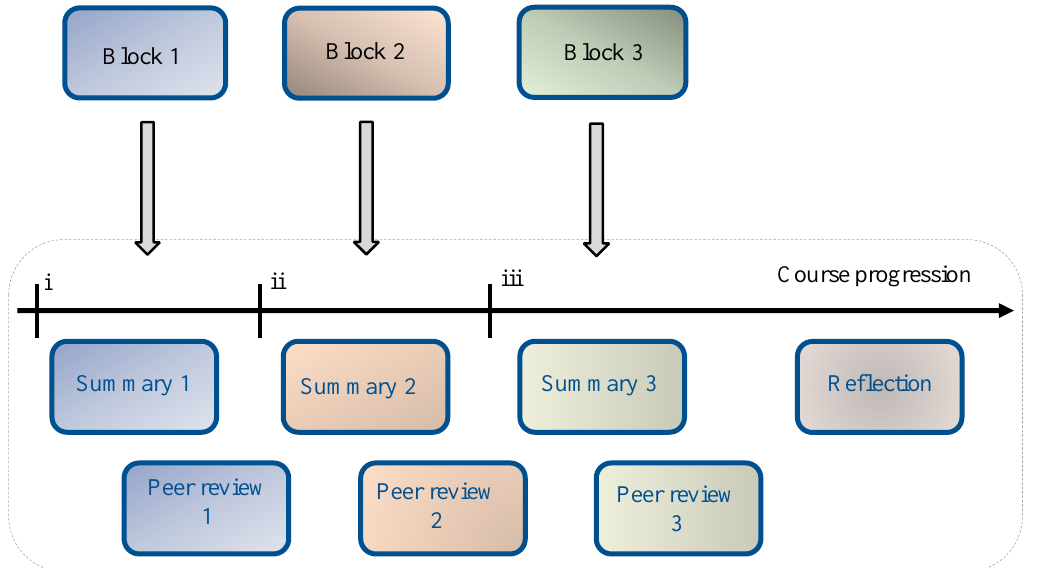
Figure 7. The three thematic blocks of the seminar and their relation to the portfolio